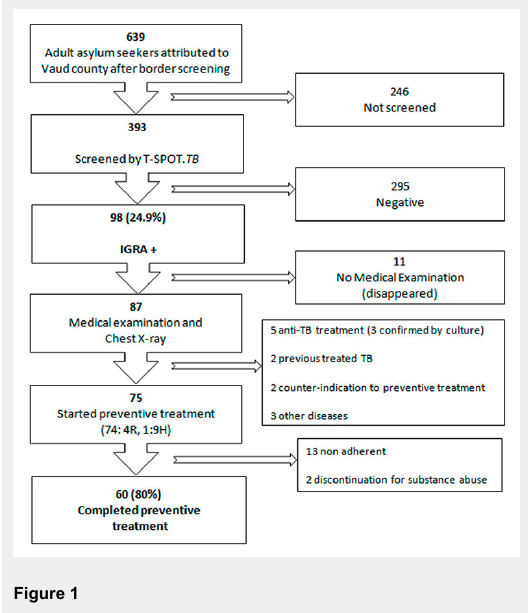
Preventive treatment completion flowchart. * IGRA = Interferon Gamma Release